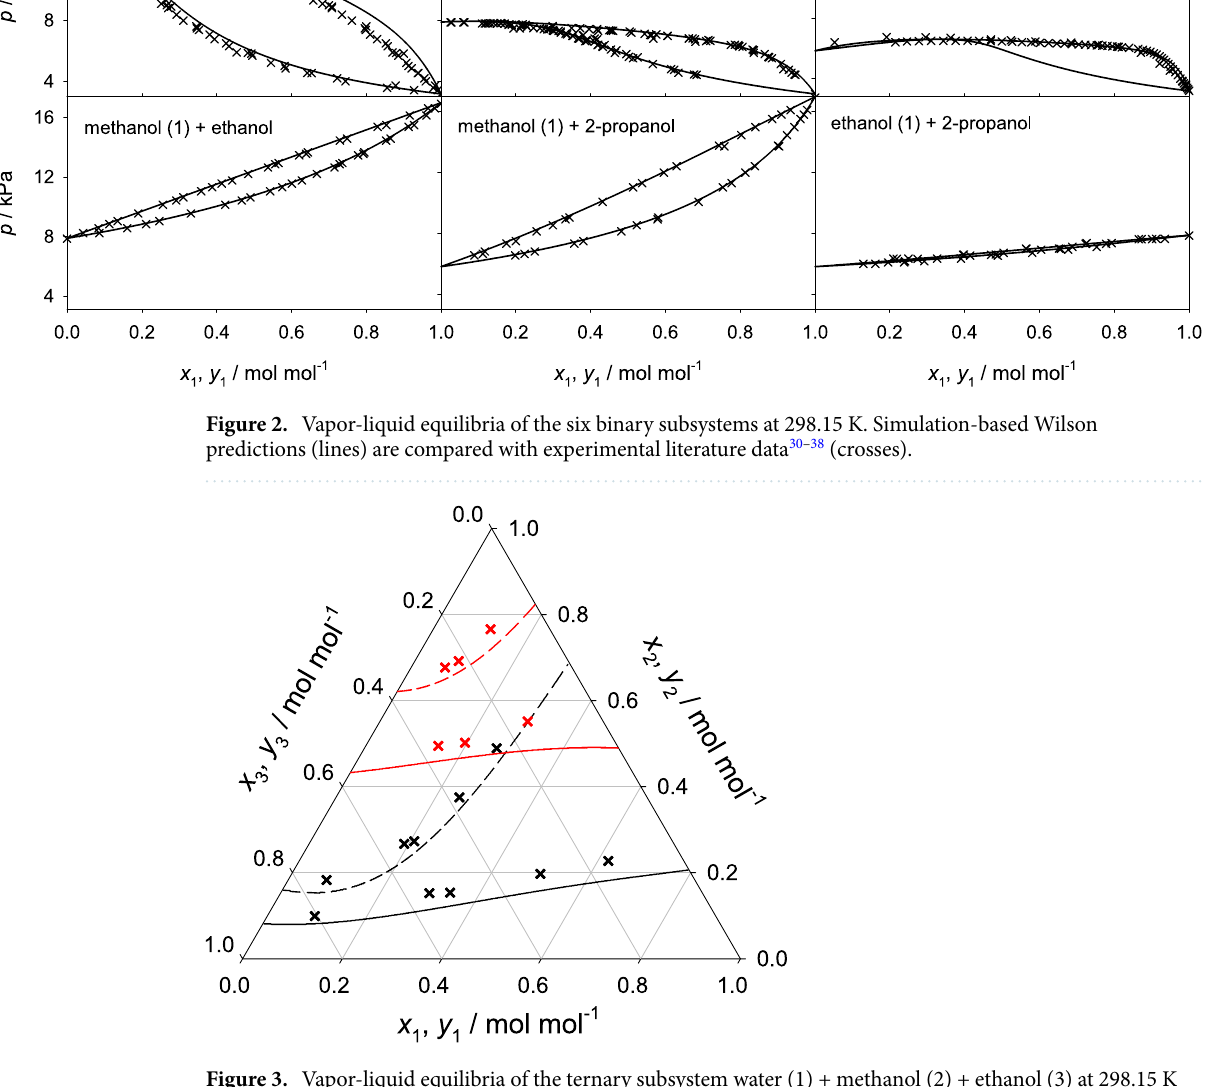
Figure 3. Vapor-liquid equilibria of the ternary subsystem water (1) + methanol (2) + ethanol (3) at 298.15 K and 11.819 kPa (red) as well as 8.628 kPa (black). Simulation-based Wilson predictions of the saturated liquid composition (line) and saturated vapor composition (dashed line) are compared with experimental literature data 39